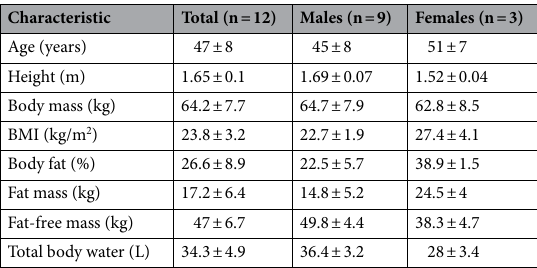
Table 1. Participant characteristics. Values are mean ± SD.